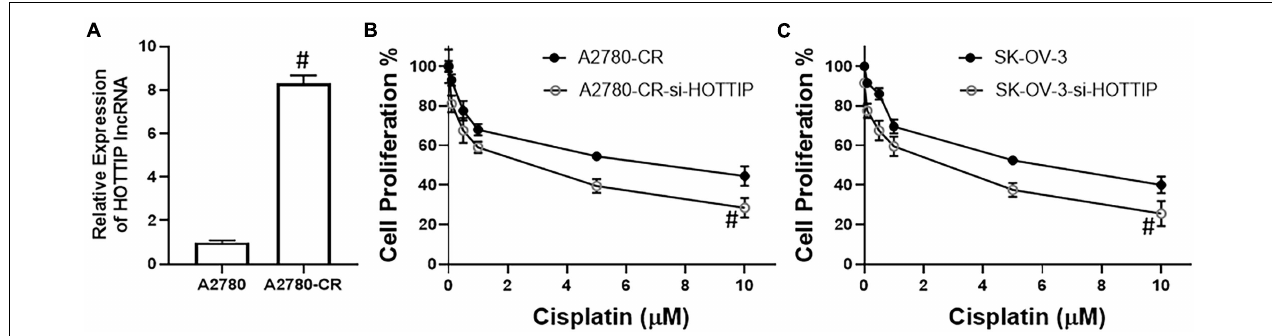
FIGURE 1 | (A) LncRNA HOTTIP was measured in parental A2780 and derivative cisplatin resistant A2780-CR cells by RT-PCR. Cell proliferation of (B) A2780-CR and (C) SK-OV-3 cells was measured by MTT assay, as described in section “Materials and Methods.” Cells were treated with indicated final doses of cisplatin for 72 h before the MTT assay. # p <